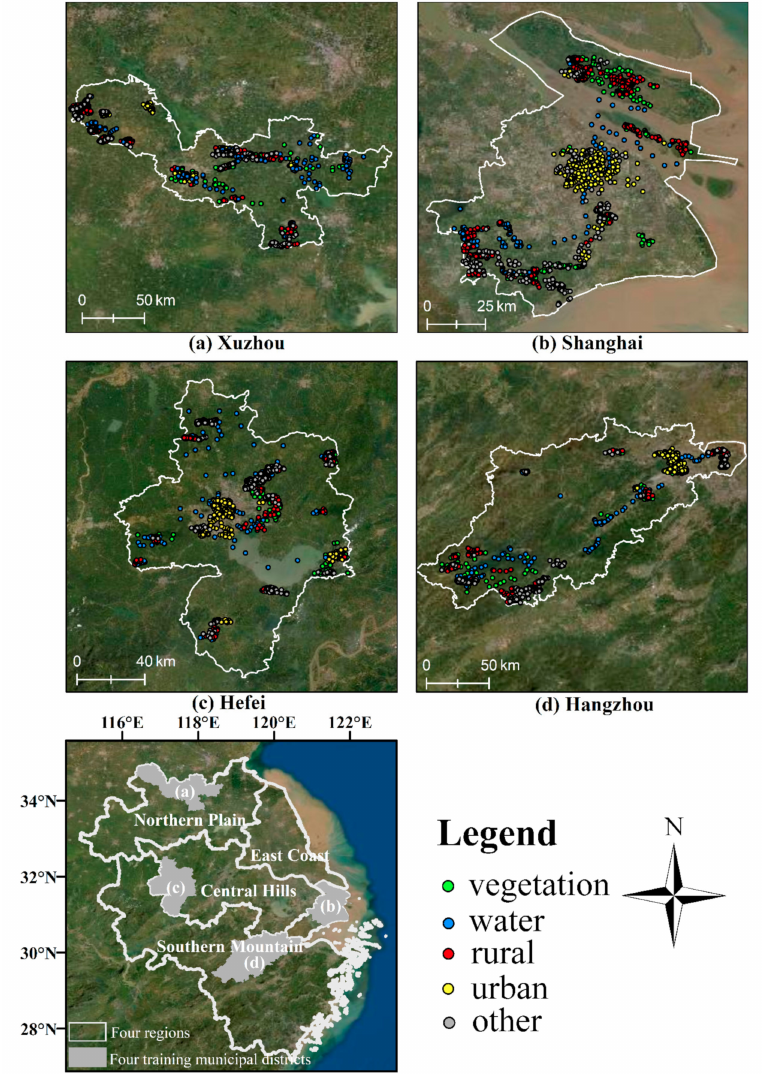
Figure 3. Divisions of the study area and distribution of training samples. Training samples in ( a ) Xuzhou, Northern Plains; ( b ) Shanghai, East Coast; ( c ) Hefei, Central Hills; and ( d ) Hangzhou, Southern